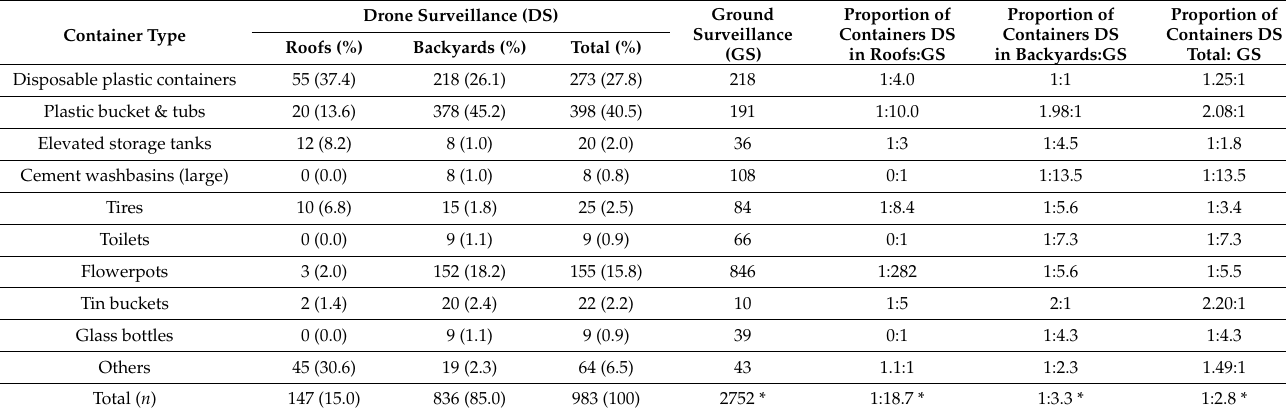
Table 2. Total number of containers detected by drone (DS) and ground surveillance (GS) as potential breeding sites for Aedes aegypti in the locality of El Vergel, Tapachula, Mexico, 13 August–6 September 2019. Only 10 of the 26 container types were detected by drone surveillance; therefore, data of ground surveillance from these types of containers was considered in this table for comparison proposes.